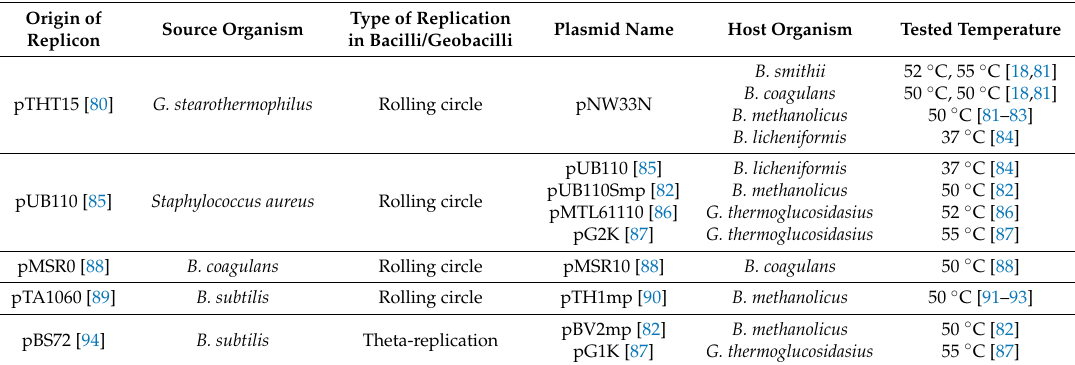
Table 2. Plasmid vectors for thermophilic